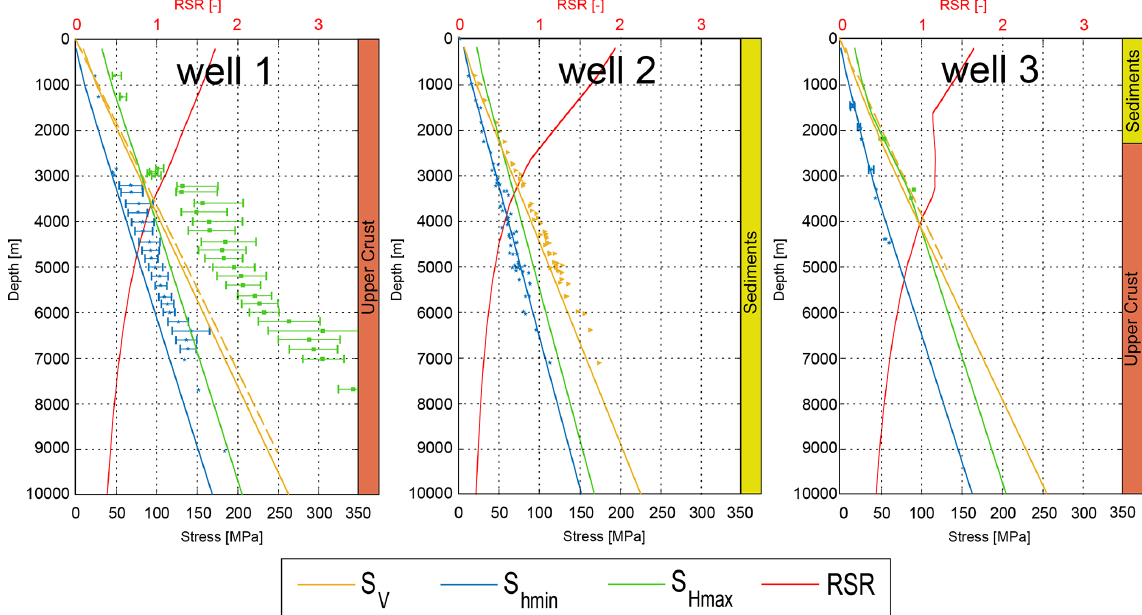
Figure 10. Gradients of regime stress ratio (RSR), S V , S hmin and S Hmax for three hypothetic wells in comparison with data. The orientation of S Hmax (not shown here) is constant over the entire depth (well 1: 161 ◦ , well 2: 163 ◦ , well 3: 162 ◦ ). The colored lines show the RSR (red), the stresses of S V (yellow), S hmin (blue) and S Hmax (green). Blue stars and green rectangles show measured respectively calculated magnitude of S hmin and S Hmax . The uncertainties of the magnitudes if specified are displayed as error bars. Yellow dotted lines are calculated S V from density data. Well 1: comparison data from the “Kontinentale Tiefbohrung” (KTB) of Brudy et al. (1997). Well 2: comparison data from the NGB of Röckel and Lempp (2003). Well 3: comparison data from Soultz-sous-Forêts and Rittershoffen. Measured S hmin magnitudes of Valley and Evans (2007), calculated S Hmax values of Klee and Rummel (1993), and calculated S V magnitudes based on density values of Azzola et al.